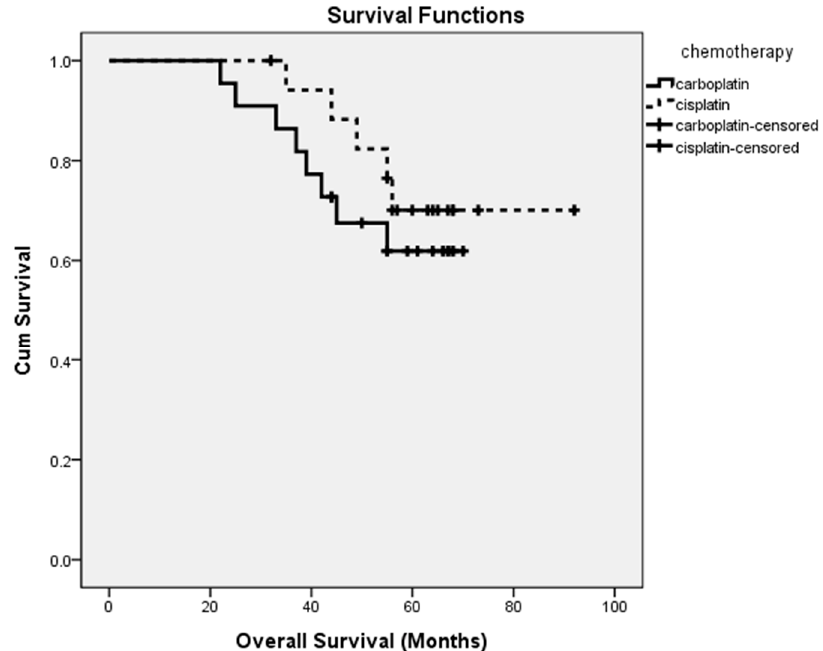
Figure 2. Overall survival curves of patients for patients treated either with carboplatin-based dose-dense chemotherapy or with cisplatin-based dose-dense chemotherapy.